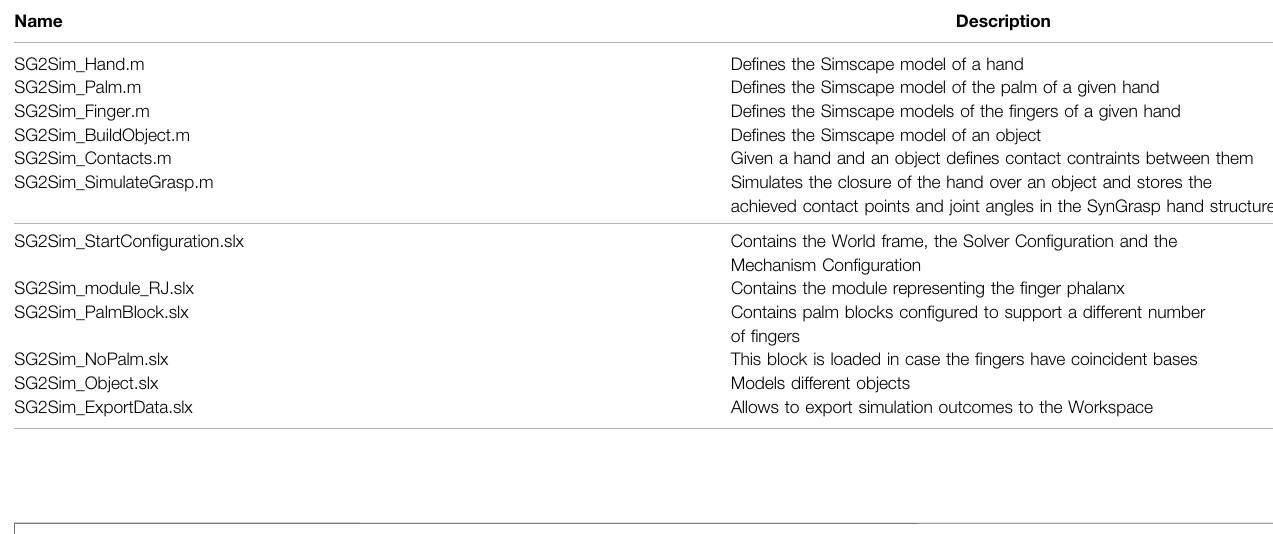
TABLE 1 | Implemented MATLAB functions and Simulink blocks.